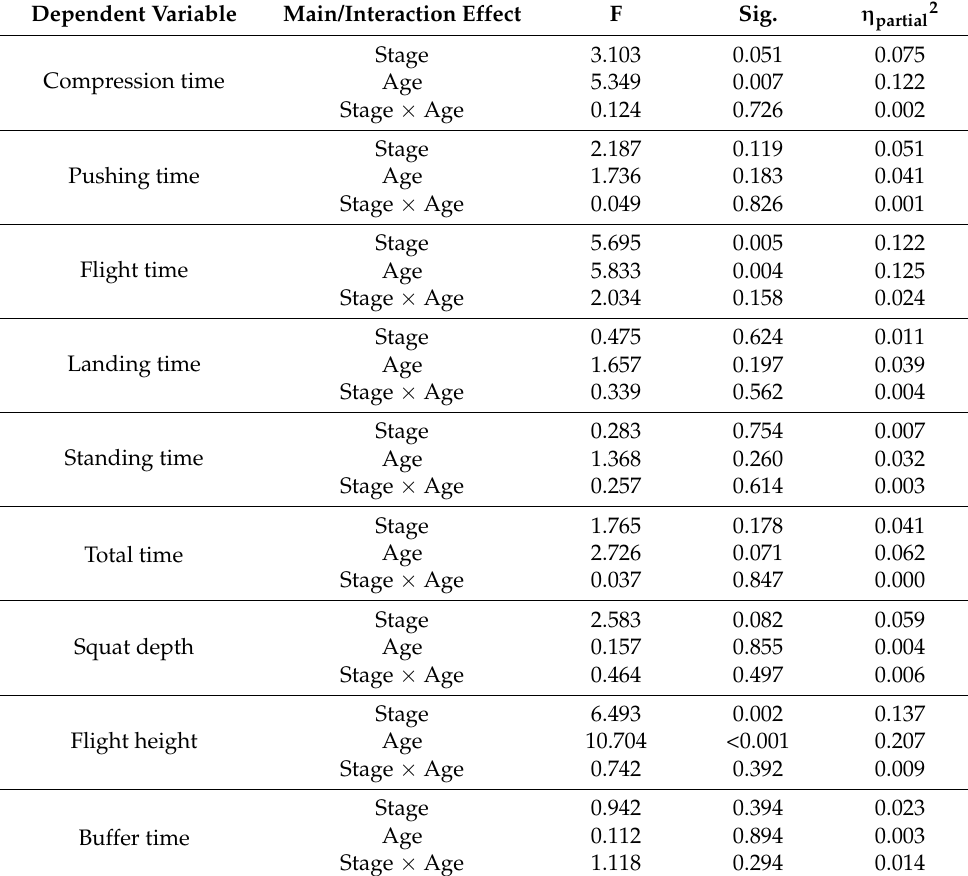
Table 3. Results of main and interaction effect of spatiotemporal